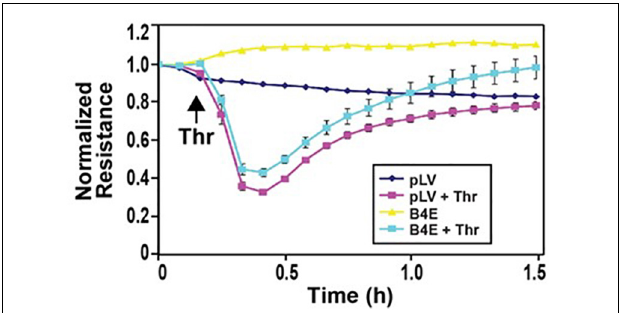
FIGURE 7 | ITGB4E overexpression attenuates thrombin-induced EC barrier disruption. Human pulmonary artery ECs were transfected with ITGB4E or control vector and then plated on polycarbonate wells containing evaporated gold microelectrodes followed by treatment with thrombin (1 U/ml), a barrier- disruptive agonist, or vehicle and TER was measured. Thrombin-induced barrier disruption was attenuated in ITGB4E-overexpressing cells as evidenced by a greater nadir and a slower time to recovery in thrombin-treated control ECs ( n = 3 independent experiments, p < 0.05 for ITGB4E-transfected cells compared with controls at each time point